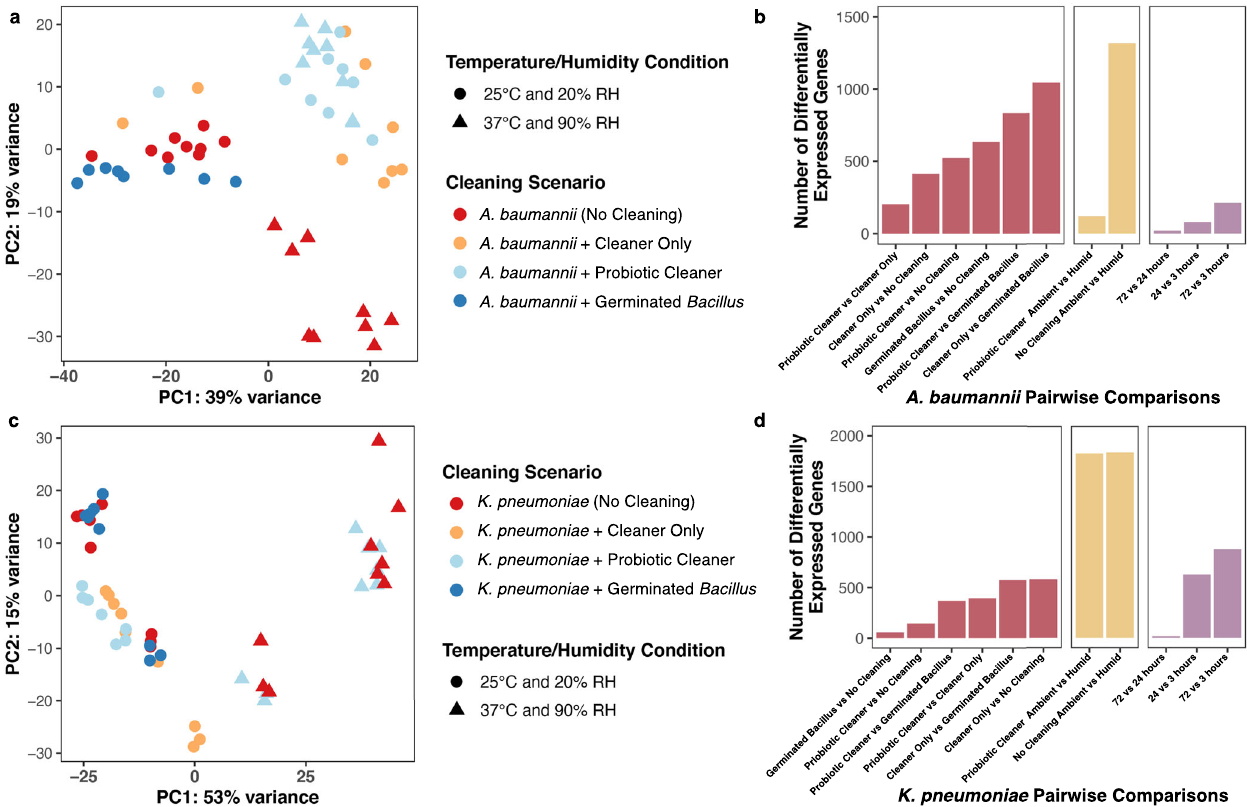
Fig. 3 Variations in transcriptomes of pathogens on surfaces. Principal component analysis on variance stabilized A. baumannii ( a ) and K. pneumoniae ( c ) read counts and number of differentially expressed genes of 11 pairwise comparisons for A. baumannii ( b ) and K. pneumoniae ( d ) experiments. Samples were color-coded based on cleaning conditions; each point (dot or triangle) represents its corresponding temperature and humidity